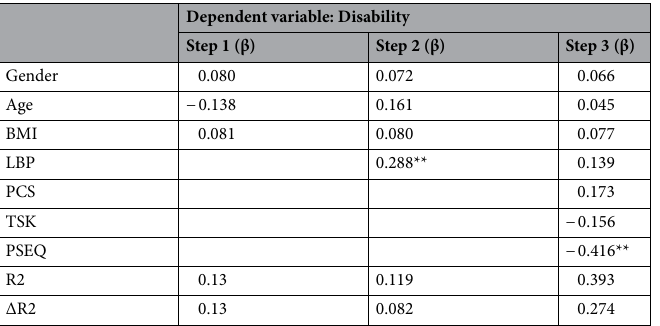
Table 5. Results of hierarchical linear regression analysis for non-acute NSLBP group (n = 111). *p < 0.05, **p < 0.01. β Standardized coefficients, NSLBP non-specific low back pain, LBP low back pain, BMI Body Mass Index, PCS Pain Catastrophizing Scale, TSK Tampa Scale for Kinesiophobia, PESQ Pain Self Efficacy Questionnaire, RMDQ Roland Morris Disability Questionnaire, R 2 the proportion of explained variance in dependent variable by the model, ΔR 2 the change in R 2 values from one model to